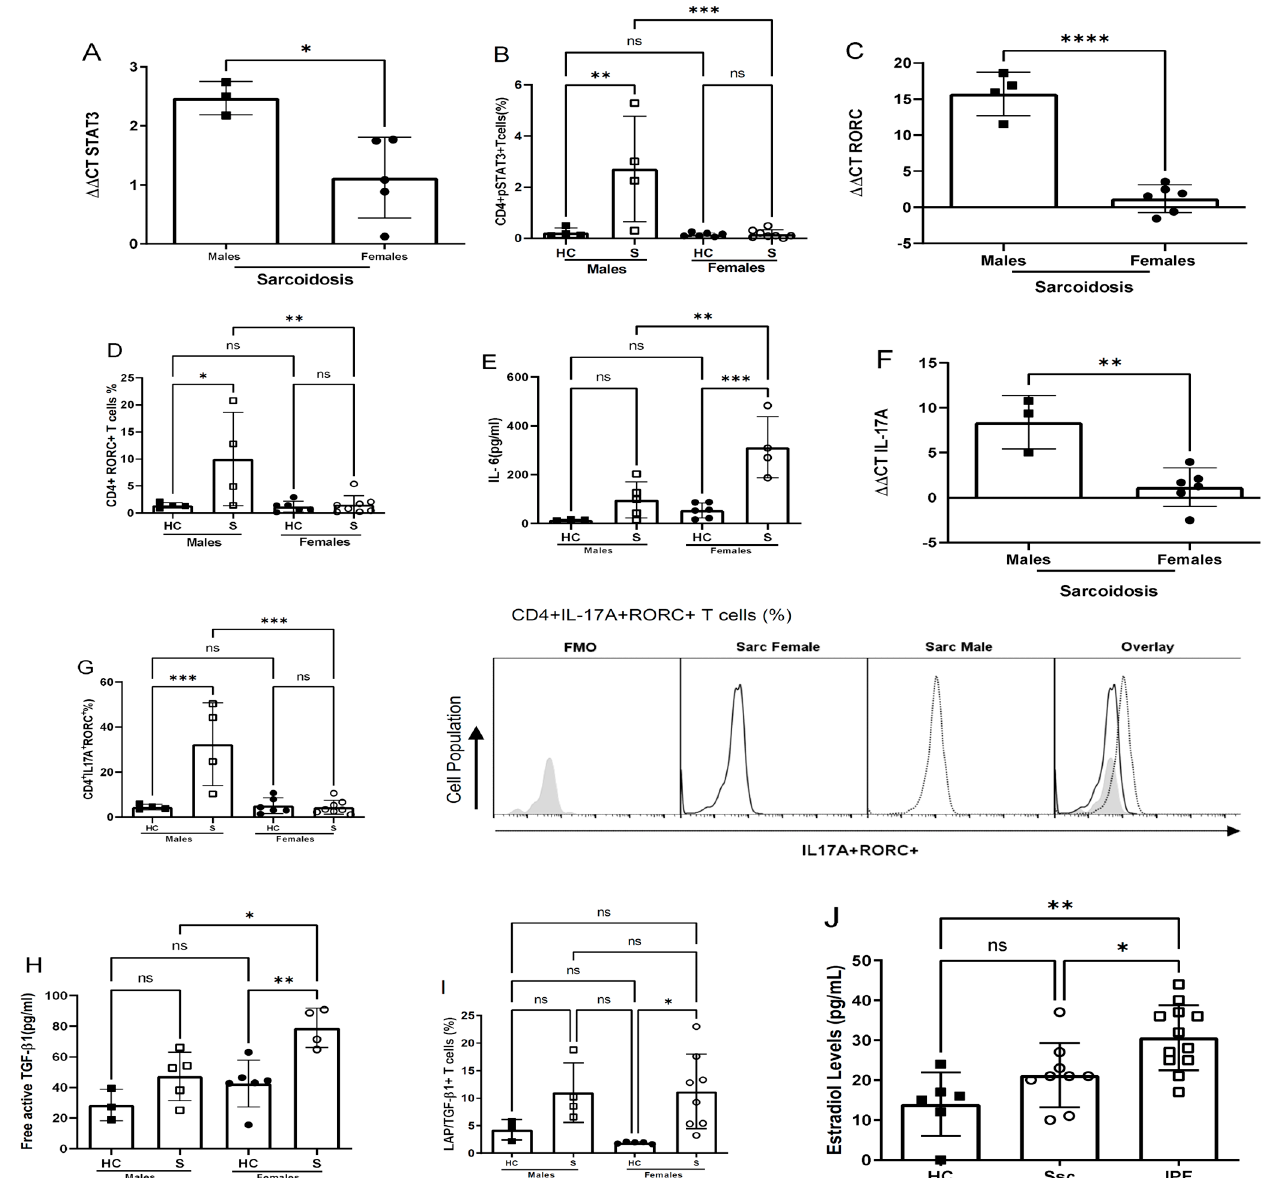
Figure 6. Male and female sarcoidosis patients display distinct profibrotic cytokine profiles . Purified CD4+ T cells from the peripheral blood of healthy controls and sarcoidosis patients were anti-CD3- and anti-CD28 TCR-stimulated and cultured for 24 h, followed by real time-PCR for ( A ) STAT3, ( C ) RORC, ( F ) IL-17A; flow cytometry for ( B ) pSTAT3Y705, ( D ) RORC, ( G ) IL-17A, ( I ) LAP/TGF- β 1; ( E ) cytokine bead array for IL-6 and ( H ) enzyme-linked immunosorbent assay for free TGF- β 1 analysis. ( J ) Estradiol levels in serum of healthy controls, IPF and scleroderma male patients. Comparisons between cohorts were performed using one-way ANOVA with Tukey’s post hoc test. Bars are the mean ± SD; each dot is an individual patient. * p < 0.05, ** p < 0.01, *** p > 0.001, **** p < 0.0001. ns: no significance, HC: healthy controls, S: sarcoidosis, Ssc: systemic sclerosis, IFP: idiopathic pulmonary fibrosis.